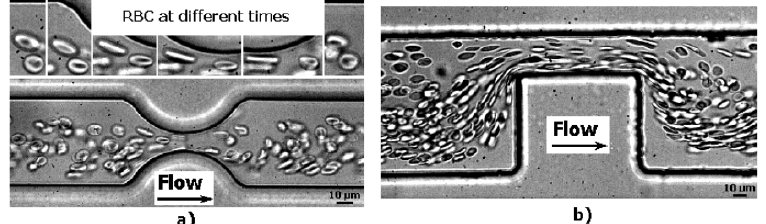
Figure 5. RBCs flowing through a microchannel with ( a ) a smooth and ( b ) a sudden (or abrupt) contraction (adapted from [65]).